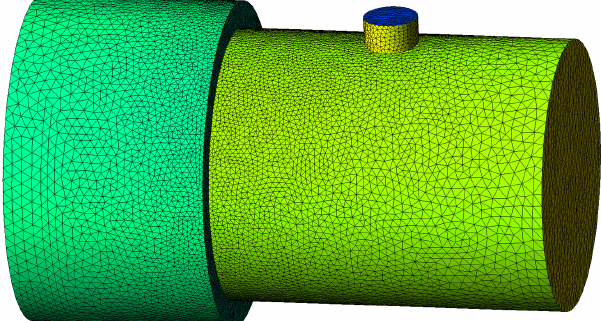
FIG. 10. The beam pipe discretized boundary with two seg- ments of differing radius and a small circular opening. The boundary mesh scale is adaptively reduced near the geometric features to